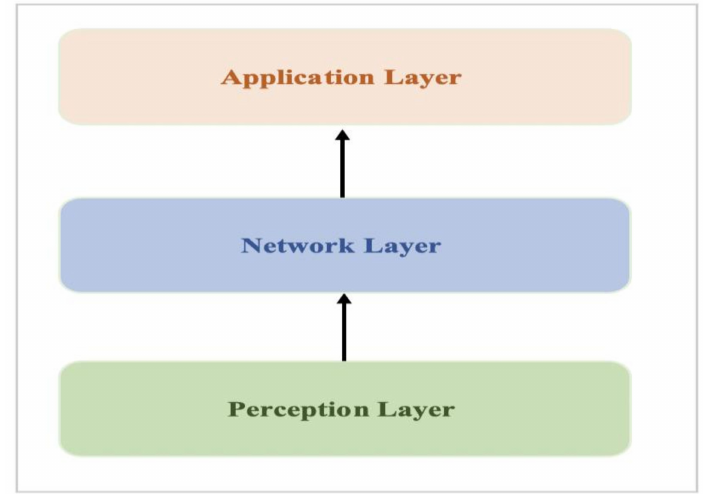
Figure 1. Three layers IoT